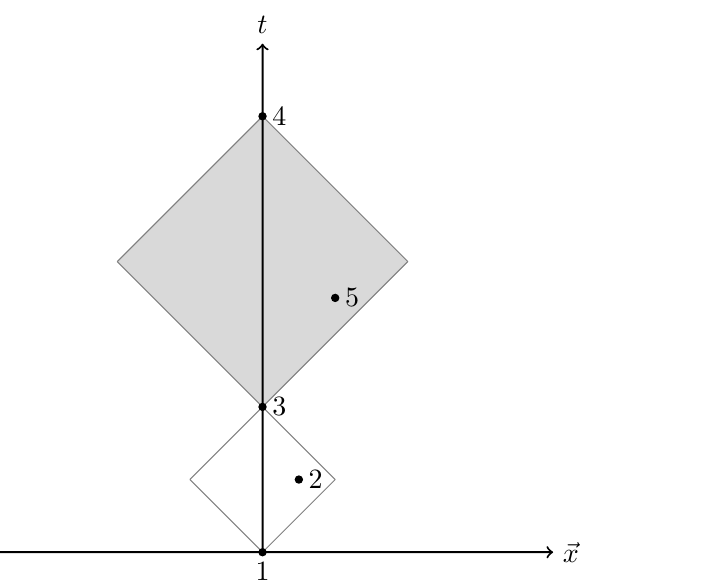
Figure 21 . The gray area is the integration region for x (cid:22) for the conformal